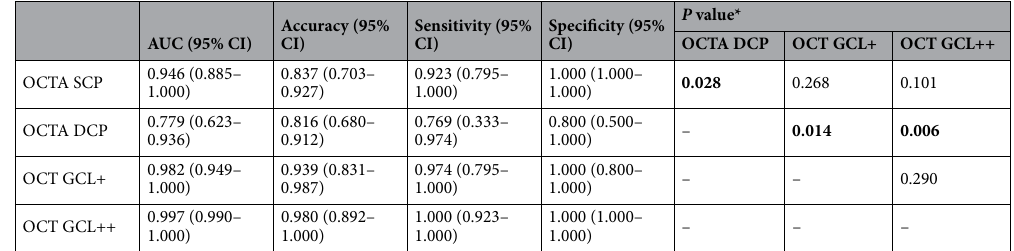
Table 2. Performance of deep learning model in distinguishing highly myopic glaucoma from healthy high myopia. AUC area under the receiver operating characteristic curve, CI confidence interval, DCP deep capillary plexus, GCL + ganglion cell layer + inner plexiform layer, GCL ++ retinal nerve fiber layer + ganglion cell layer + inner plexiform layer, OCT optical coherence tomography, OCTA optical coherence tomography angiography, SCP superficial capillary plexus. Boldface indicates P < 0.05. *DeLong’s